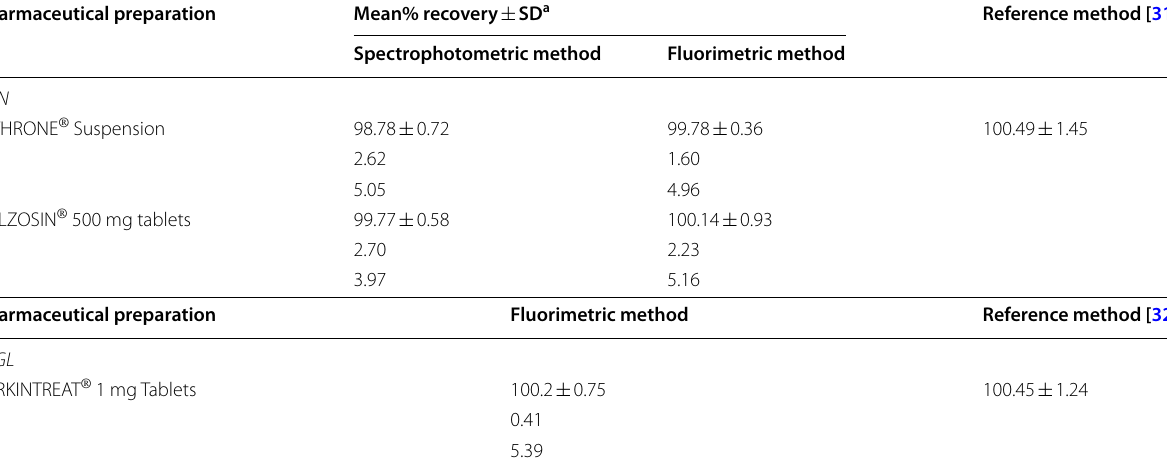
a Mean standard deviation of three determinations ± b COMPARATIVE method represents the tabulated data of t and F at P